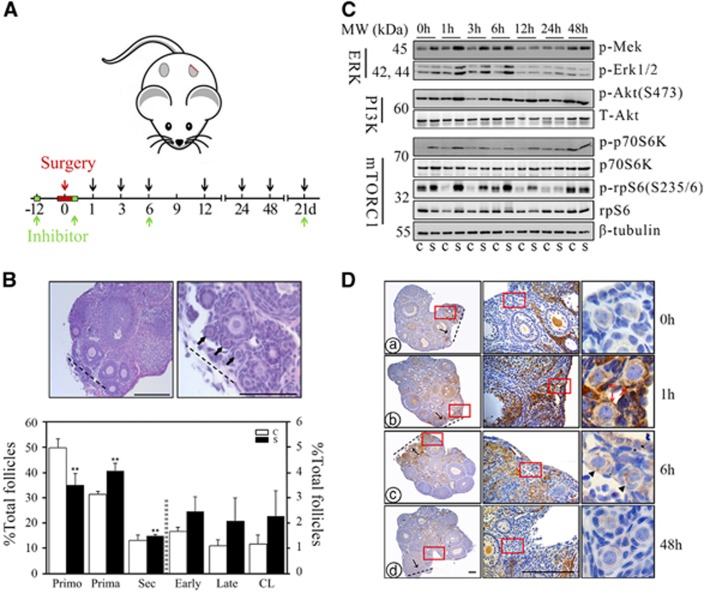
Acceleration of follicular activation and development after ovarian resection. (A) Timeline for collecting ovaries after surgery. One-third of one ovary of a pair was resected and the contralateral ovary was remained undamaged as control. Ovaries were collected at 1 h, 3 h, 6 h, 12 h, 24 h, 48 h, or 21 days after surgery. Two injections of inhibitors were administered 12 h before and shortly after the operation, and ovaries were collected at 6 h or 21 days, respectively (green arrows). (B) Injury induced an increase in ovarian development. Ovaries were collected 3 weeks after surgery. Upper panel, ovarian histology using hematoxylin and eosin (H&E) staining. Dotted line, original surgical incision. Arrows, clusters of primary follicles. Lower panel, distribution of follicles in paired control (C) and surgically treated (S) ovaries (n=5). Data are shown as means±S.E.M. **P<0.01, compared with controls. Primo, primordial follicle; Prima, primary follicle; Sec, secondary follicle; Early, early antral follicle; Late, late antral follicle; CL, corpus luteum. (C) Western blots of ovarian proteins using specific antibodies for p-Mek, p-Erk1/2, p-Akt (S473), Akt, p-p70S6k (T389), p70S6k, p-rpS6 (S235/6), rpS6, and β-tubulin. β-Tubulin was used as a loading control. (D) Dynamic changes in p-rpS6 near the incision site at 0 h (a), 1 h (b), 6 h (c) and 48 h (d) after surgery. Middle and right panels, higher magnifications of left panel showing primordial follicles near the incision. Red frames, magnified views were shown in the middle and right panels, respectively. Dotted line, surgical incision. Black arrows, localized expression of p-rpS6 near the incision. Red arrows, pre-granulosa cells. Black arrow heads, primordial oocytes. All bars=100 μm